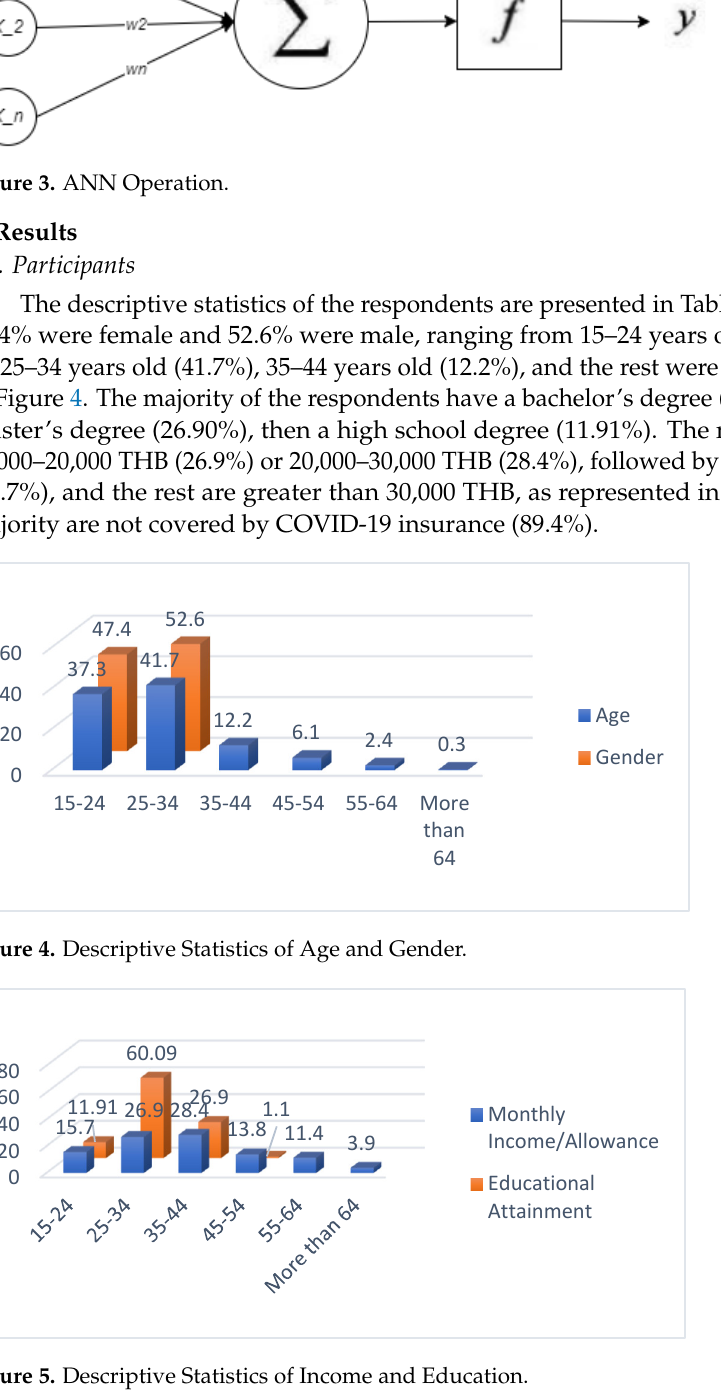
Table 2. Validity and Multicollinearity.